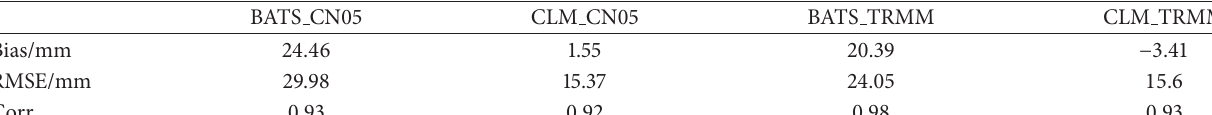
Table 3: Statistical values between the simulated and observed precipitation.